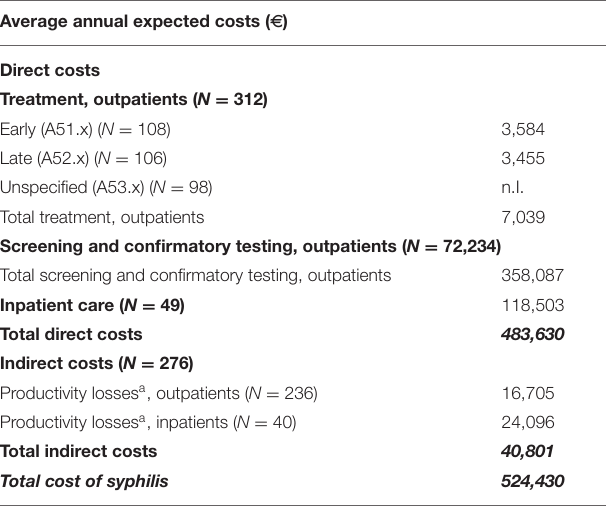
TABLE 3 | Economic burden of syphilis in the insurance study population. Missing data was coded n.I. (no